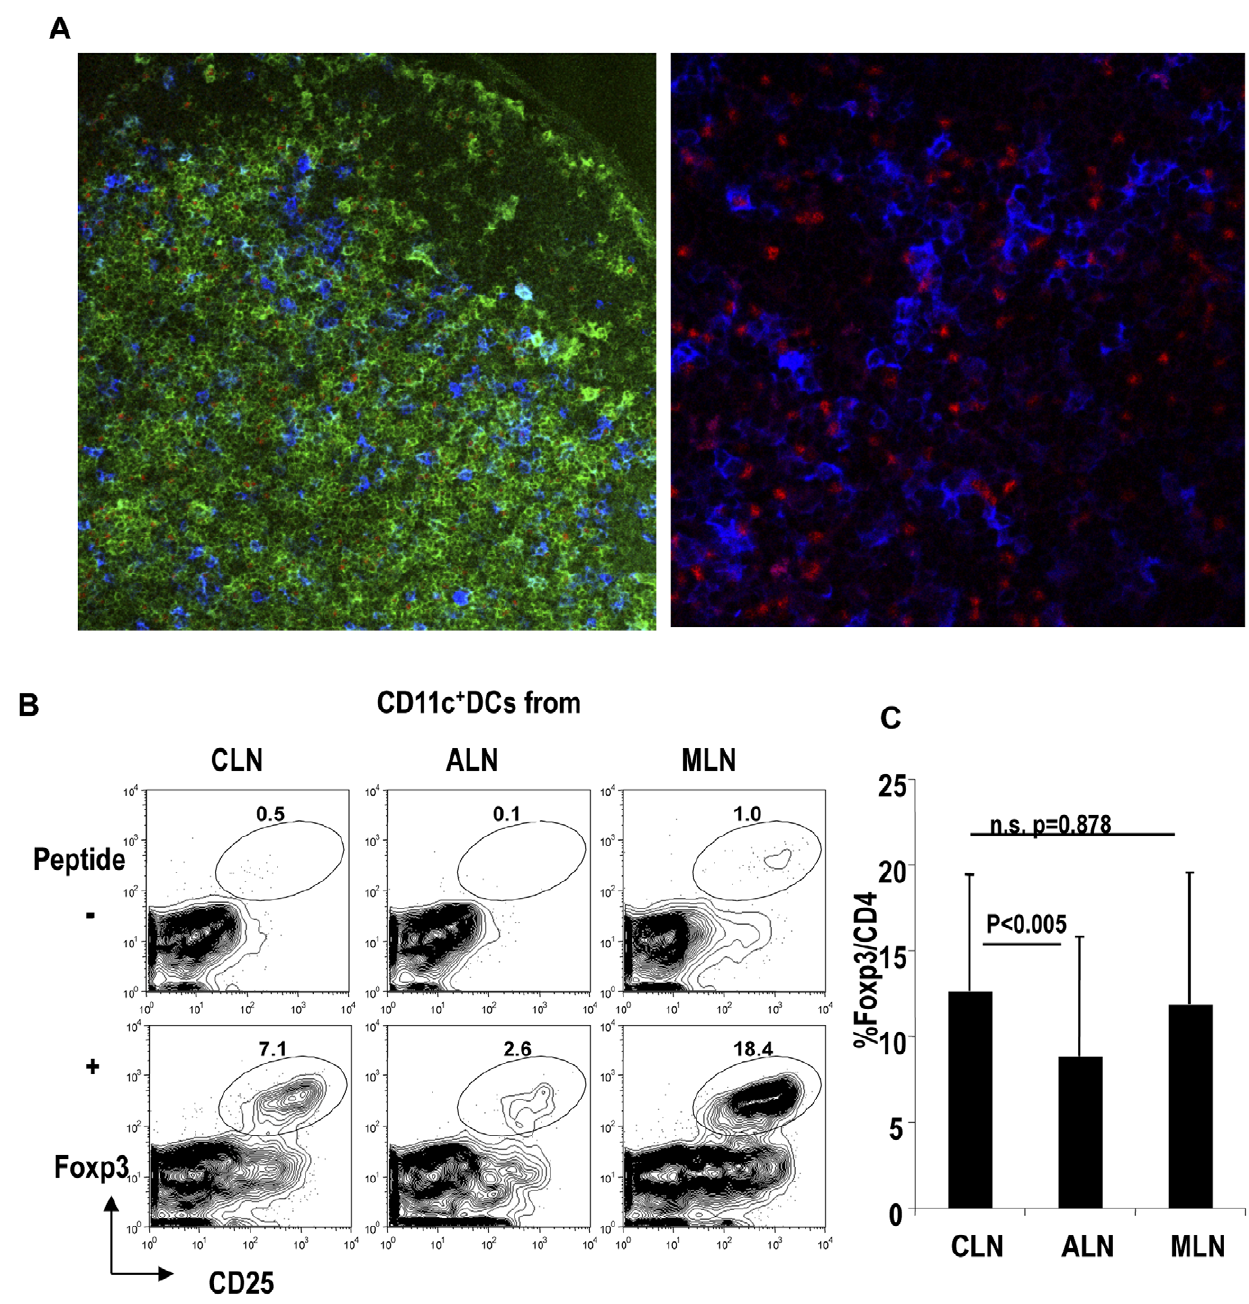
Figure 4. Dendritic cells from oral-cavity-draining cervical lymph nodes induce Foxp3 + T-regs. (A) CLNs were stained with Foxp3 (red), CD4 (green) and CD11c (blue). Representative of three similar separate experiments. (B) OT II CD4 + T cells (5 6 10 4 ) were cultured with dendritic cells (DCs) from CLN, ALN, or MLN (5 6 10 4 ) with or without OVA peptide. After 5 days, cells were stained with Foxp3, CD25 and CD4. The plots were gated on CD4 + T cells. Representative of four separate experiments. (C) As in (A), but the graphic shows a summary of four separate experiments. P value provided is by paired t-test. ‘‘n.s.’’=‘‘not significant’’.